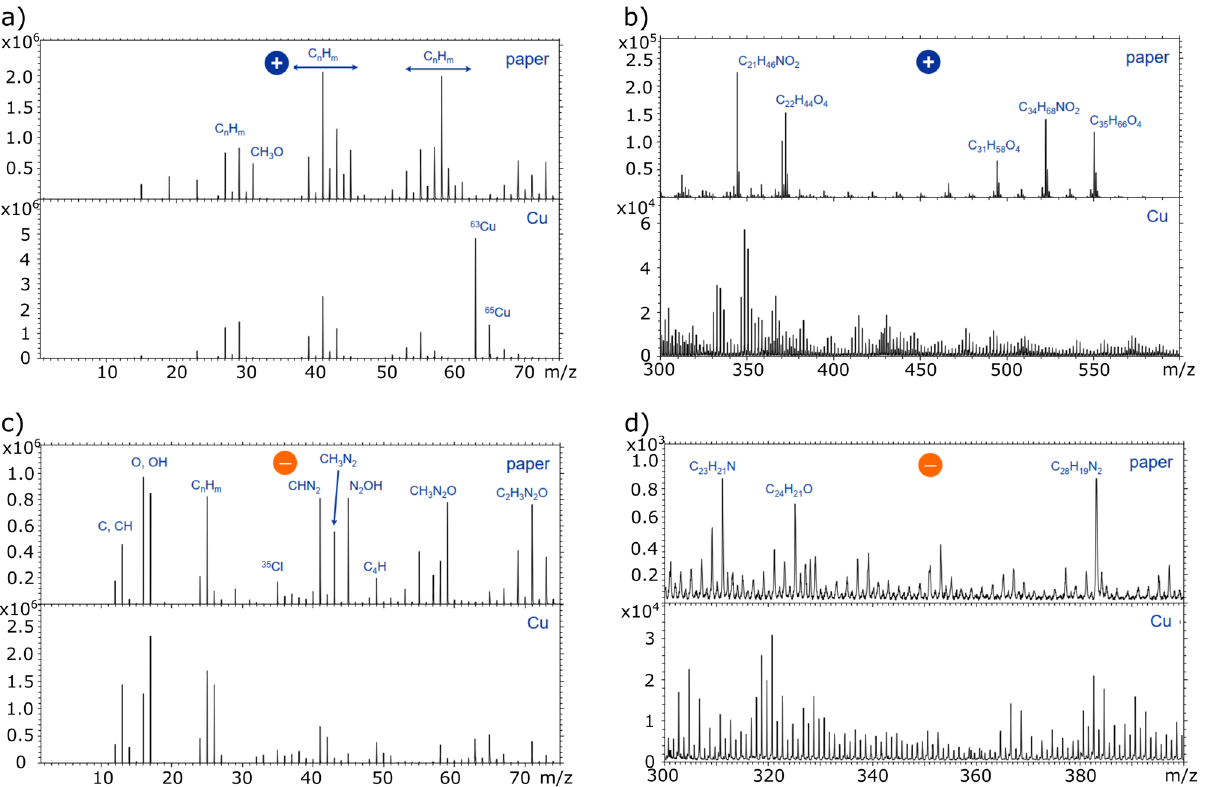
Figure 3. Positive ( a,b ) and negative ( c,d ) secondary ion spectra received on the stored sample (‘Cu’) and on the paper (‘paper’) sample are shown in a region of low masses (< 75 amu) and in a region of higher masses (> 300 region). The low mass secondary ion spectra of the Cu sample indicate a rather clean metallic sample with slight contaminations of typical environmental simple hydrocarbons. Some corresponding peaks are also found on the paper, but the observed peak groups differ. In the region of higher masses (> 300 amu), which is significant for more complex organic molecules, the dominant peaks found on the paper at 311, 325